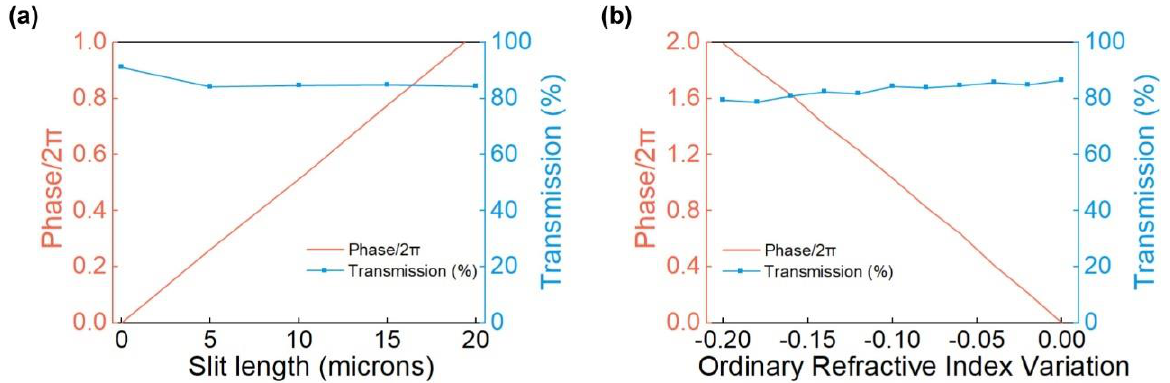
Figure 2. Simulation scanning results of phase and transmission of the element structure. ( a ) Calculation results of the slit waveguide with the length varying from 0 to 20 µ m. The phase coverage of the slit waveguide with a length of 20 µ m can reach 2 π , whereas the transmission is greater than 80%; ( b ) Simulation results of voltage applied under the condition of ordinary refractive index ∆ n o ranging from 0 to − 0.20. | ∆ n o | almost satisfies the linear relationship with the phase, and the transmission is always greater than 80%.